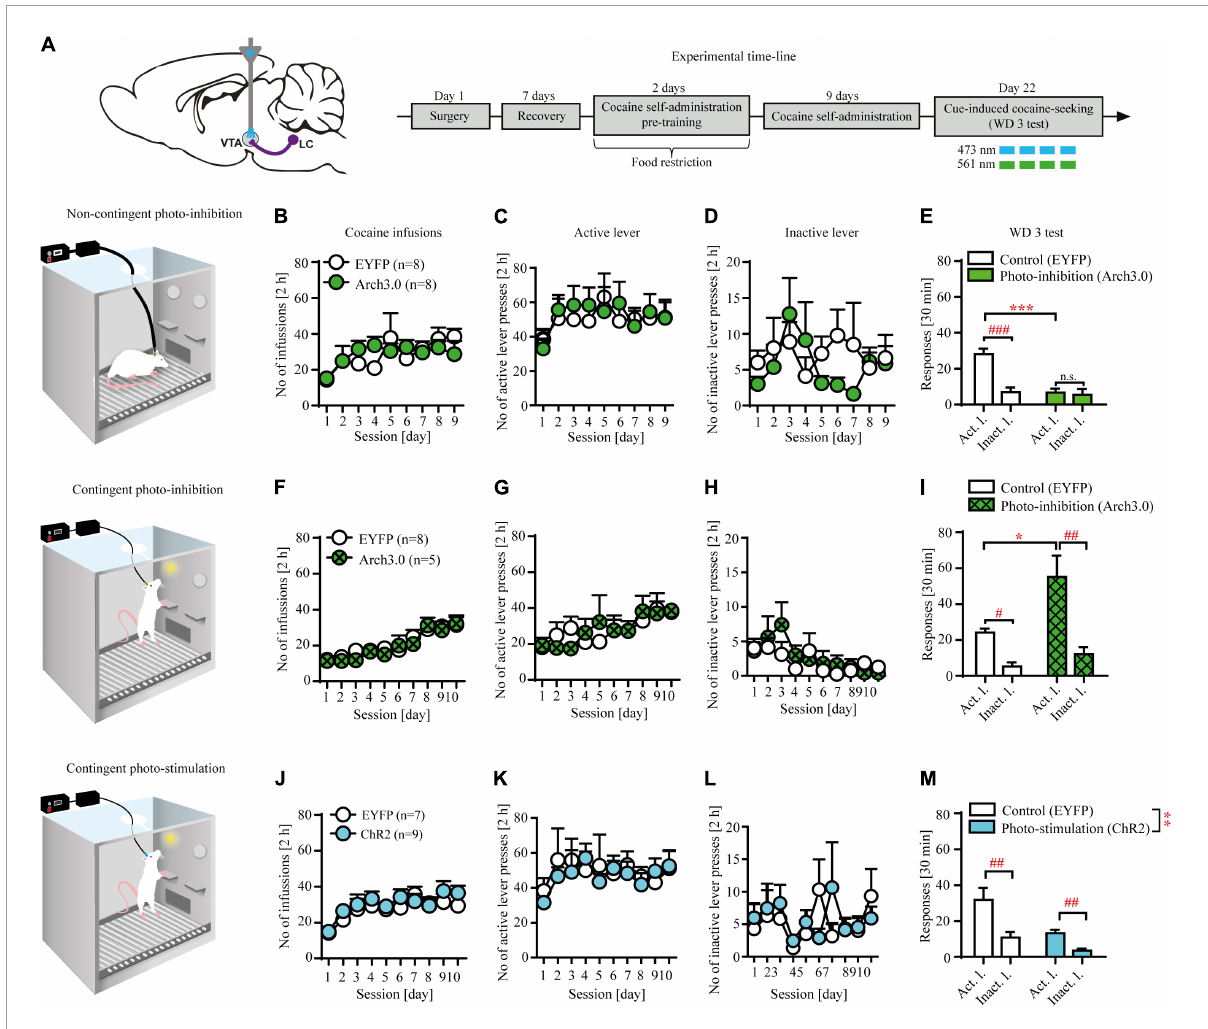
FIGURE2 Non-contingent and contingent photo-inhibition and contingent photo-stimulation of locus coeruleus (LC) efferents in ventral tegmental area (VTA) modulates cocaine seeking under extinction conditions. (A) The scheme of the photo-modulation of the VTA afferents from the LC and the experimental time-line: rats, after intra-LC viral microinjections, intra-VTA optical fiber and intravenous (i.v.) catheter implantations, recovery and operant responding pre-training, were trained to self-administer cocaine ( ∼ 0.5 g/kg/inf) for 9-10 days (2 h/day), after which they underwent forced abstinence for 3 days. On withdrawal day 3 (WD 3), rats were tested for cocaine seeking with brief, non-contingent photo-inhibition (561 nm, 1 pulse, 6 s every 12 s) or contingent photo-inhibition (561 nm, 1 pulse for 6 s) or photo-stimulation (473 nm, 360 × 10 ms pulses at 60 Hz) where active lever presses led to the presentation of CS without cocaine delivery. (B) There were no differences in the number of cocaine infusions or (C) , (D) lever responses during cocaine self-administration in future non-contingent photo-inhibition groups. (E) Non-contingent photo-inhibition of LC noradrenergic efferents in VTA on WD 3 decreased active, but not inactive lever responding in Arch 3.0-expressing group in comparison to the control group (treatment x lever: F ( 1 , 28 ) = 12.44, p < 0.01; followed by post hoc test p < 0.001) and prevented discrimination between levers compared to the control group. (F) There were no differences in the number of cocaine infusions or (G) , (H) lever responses during cocaine self-administration in future contingent photo-inhibition groups. (I) Contingent photo-inhibition of LC noradrenergic efferents in VTA on WD 3 increased active, but not inactive lever responses in Arch 3.0-expressing group compared to the control group (treatment × lever interaction: F ( 1 , 22 ) = 5.51, p < 0.05; followed by post hoc test p < 0.05). (J) There were no differences in the number of cocaine infusions or (K) , (L) lever responses during cocaine self-administration in future contingent photo-stimulation groups. (M) Contingent photo-stimulation of LC noradrenergic efferents in VTA decreased active and inactive lever responses in ChR2-expressing group in comparison to the control group (treatment: F ( 1 , 28 ) = 13.37, p < 0.01; followed by post hoc test p < 0.001; lever interaction: F ( 1 , 28 ) = 19.09, p < 0.001; followed by post hoc test p < 0.01; treatment × lever: n.s). Data are presented as the mean ± SEM.